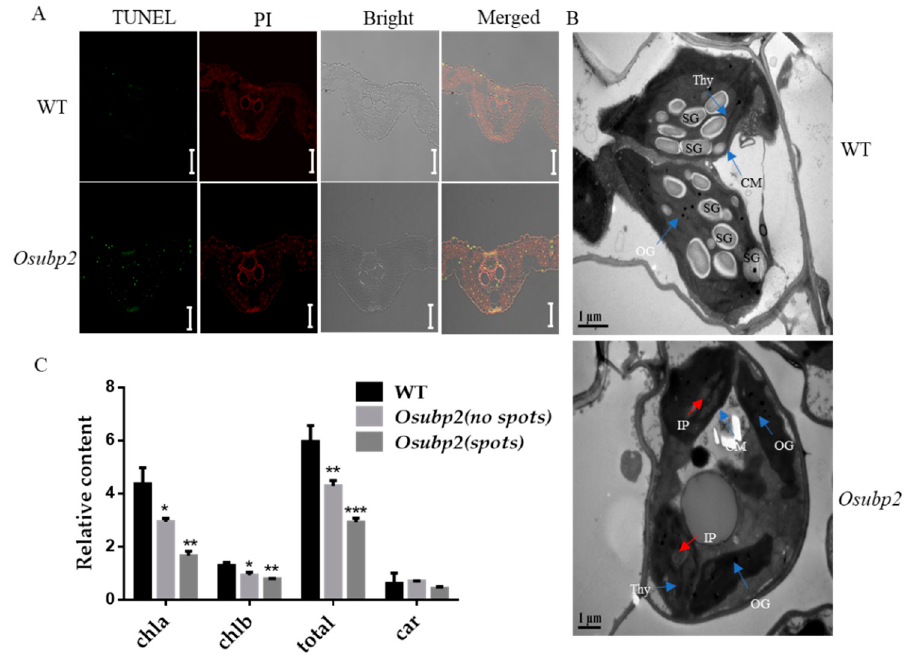
Figure 5. Mutation of OsUBP2 led to DNA damage and abnormal chloroplast morphology. ( A ) TUNEL assay in WT leaves and Osubp2 mutant leaves, red signal indicates PI (Propidium iodide) staining; green represents TUNEL-positive signals. White: white light channel; Merged: image color merged channel, Scale Bar = 50 μ m. ( B ) Chloroplast ultrastructure in WT (up) and Osubp2 mutant (below). Thy: thylakoid; CM, chloroplast membrane; SG, starch granule; OG, osmiophilic globules; IP, irregular protrusions; Scale Bar = 1 μ m. ( C ) Chlorophyll content in the flag leaves of WT and Osubp2 mutant plants at 30 days post-sowing (dps). chla: chlorophyll a; chlb: chlorophyll b; car: carotene; Error bars represent + SD ( n = 3 independent pools of leaves, three plants per pool). Asterisks indicate significant difference between the Osubp2 and WT by Student’s t -test, *** p < 0.001; ** p < 0.01; * p < 0.05.